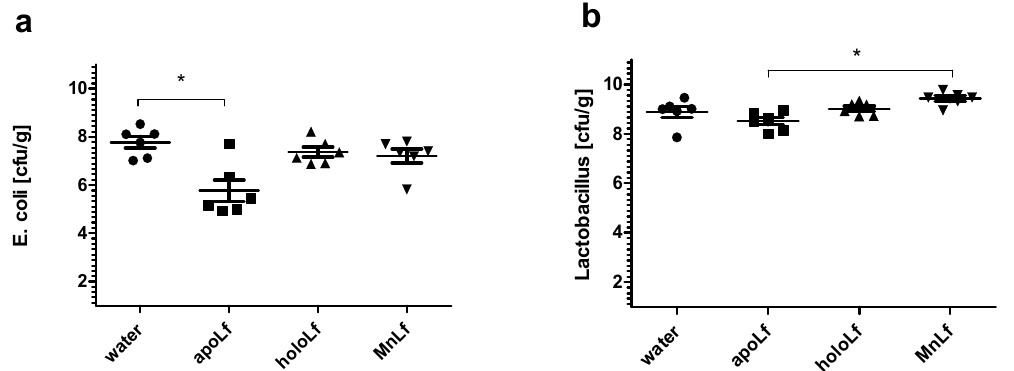
Figure 6. Quantitative assessment of population number of Escherichia coli ( a ) and lactobacilli ( b ) in fecal samples of prematurely weaned rat pups from a control group or fed with tested lactoferrin forms ( n = 6 for each group). * p < 0.05 (one-way ANOVA).